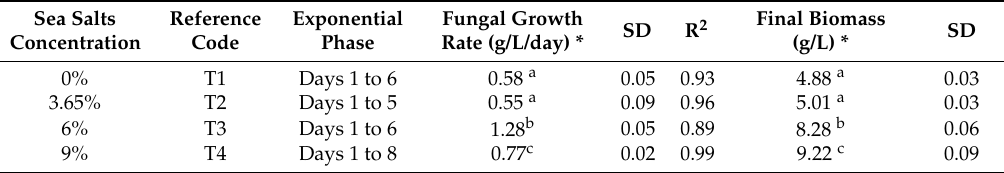
Table 3. Rates of fungal growth and final biomass weights from T. albobiverticillius 30548, based on salinity in the fermentation medium (PDB supplemented with sea salts, 27 °C, initial pH 4.0, 200 rpm of agitation rate).